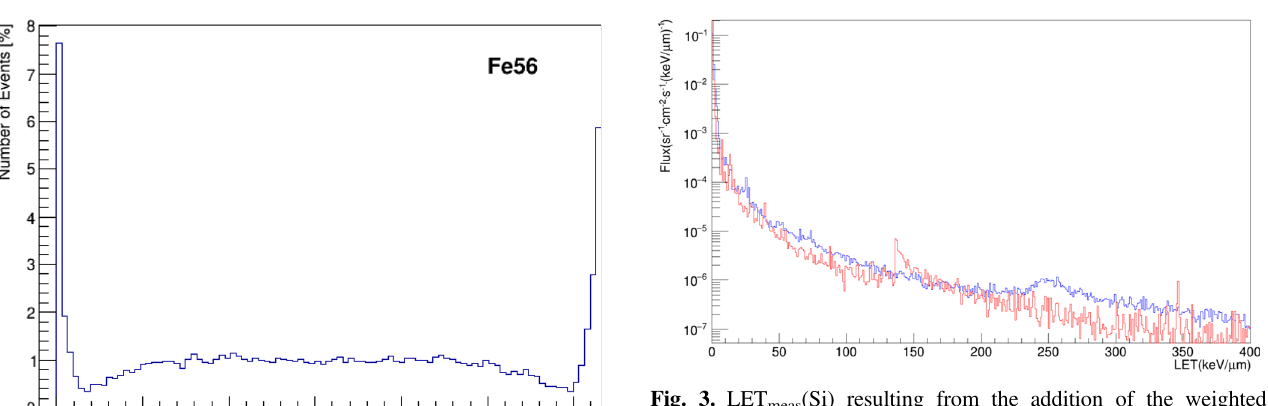
Fig. 3. LET meas (Si) resulting from the addition of the weighted distributions from all the ions with Z = 1 to Z = 26 using as weights their relative contribution to the GCR fl ux spectrum (blue) and LET H computed using the method described in the text. The bin 2 O width is 1 keV l m (cid:3) 1 .